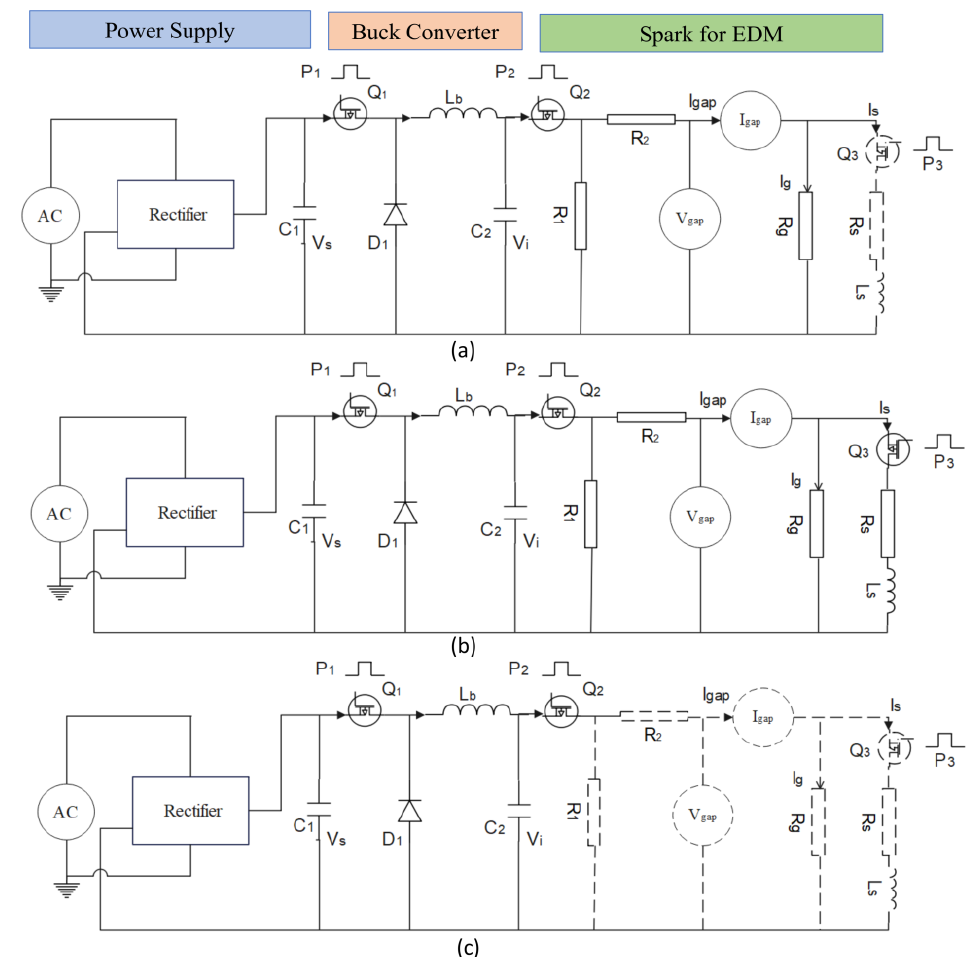
Figure 4. The model circuit and current path (solid lines) in the ( a ) ignition phase, ( b ) discharge phase and ( c ) recovery phase.